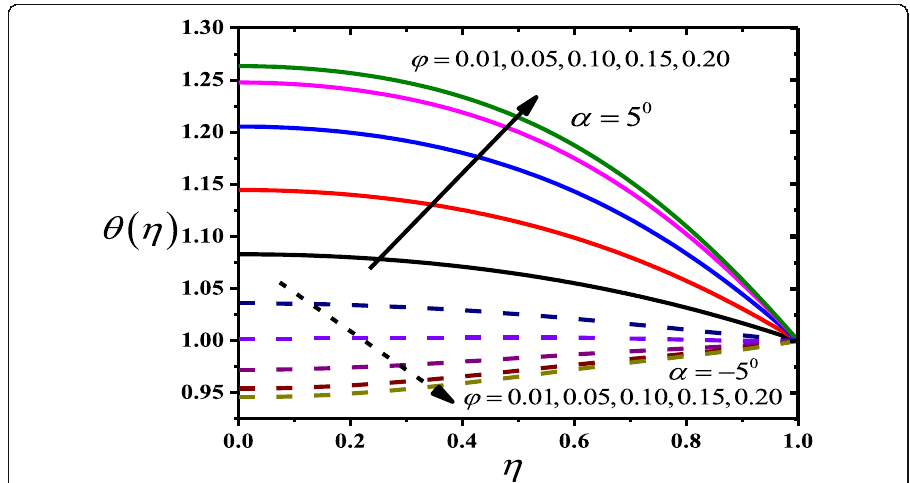
Fig. 16 Temperature vs. φ in stretching divergent and shrinking convergent channels